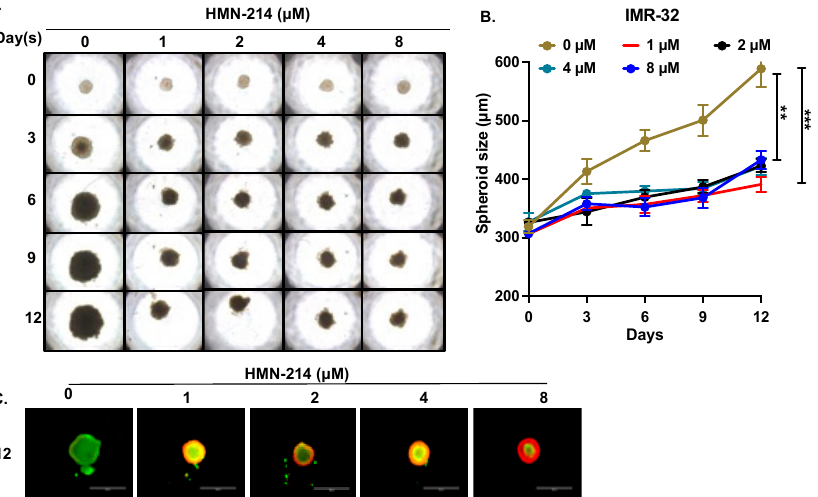
Figure 7. HMN-214 inhibits MYCN-amplified IMR-32 NB spheroid tumor growth. ( A ) Representative images of IMR-32 NB spheroidal tumors. ( B ) Spheroid tumor growth measurements in response to different concentrations of HMN-214 treatment at different days. ( C ) Representative fluorescent images of Day 12 spheroidal images stained with Calcein AM (Green; live cells) and EthD-III (Red; dead cells) fluorescence dyes. ** p < 0.01, *** p < 0.001.